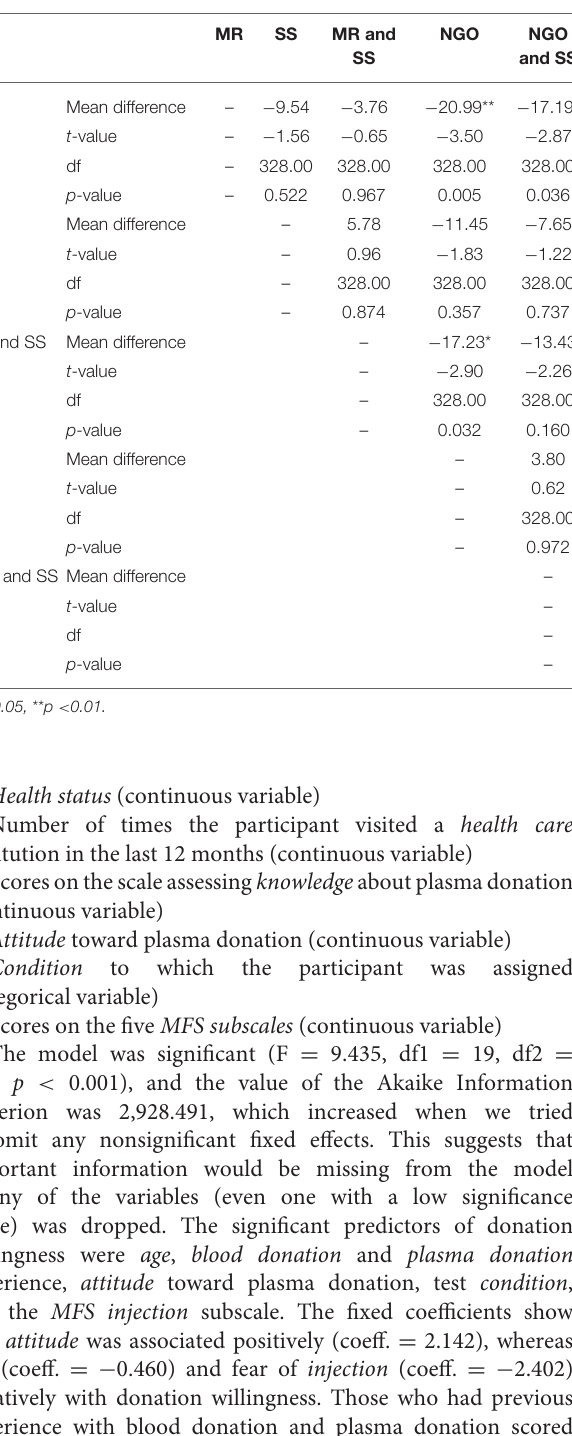
TABLE 4 | Tukey’s post-hoc test results of Fisher’s one-way ANOVA made on the donation willingness